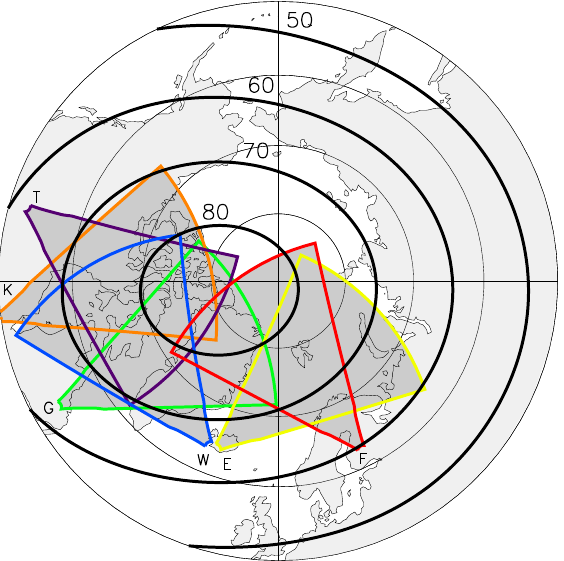
Fig. 7. Map illustrating the fields-of-view of six of the North- ern Hemisphere SuperDARN radars (CUTLASS Finland (F), CUT- LASS Iceland (E), Iceland West (W), Goose Bay (G), Kapuskasing (K), and Saskatoon (T)). The bold lines represent lines of constant AACGM latitude (values as